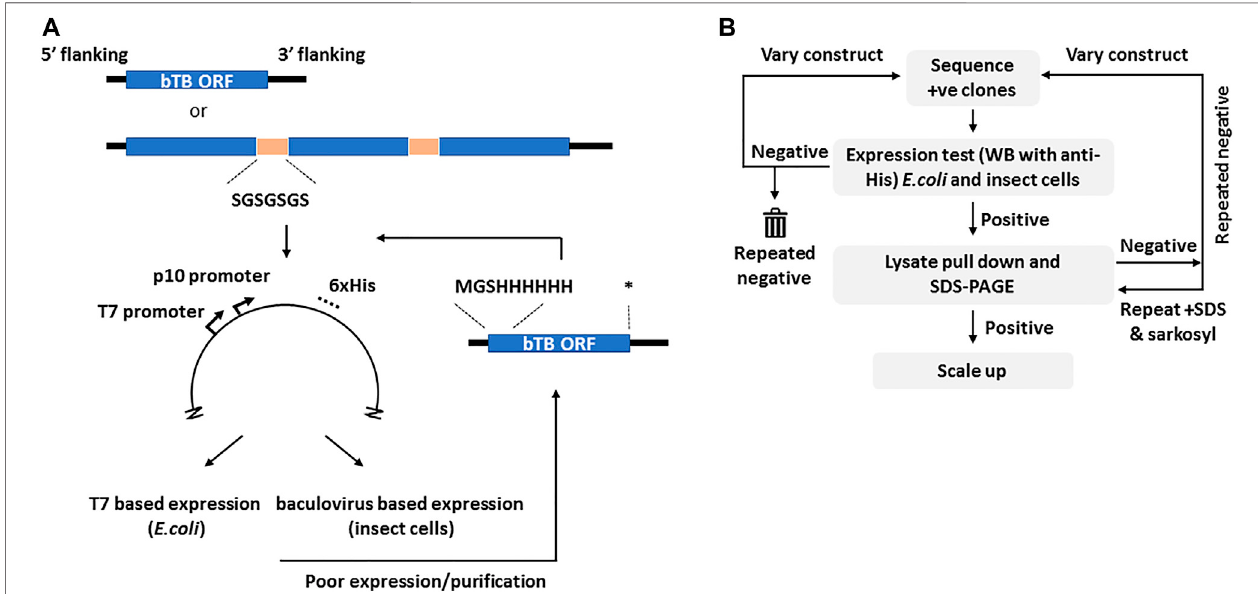
FIGURE 1 | The cloning and selection strategies for the generation of the M. bovis recombinant protein atlas. Panel (A) . Generic construct design showing the use ofeithercompleteorconcatenatedORFstaggedattheC-terminuswithpolyhistidineaspresentinvectorpTriEx1.1.IntheeventofpoorexpressionthesameORFswere re-cloned with an N-terminal His tag as shown. The sequence of the fl exible linker is indicated. Asterisk – stop codon. Panel (B) . The protein expression and puri fi cation regimen showing the iterative nature of the process. The varied constructs are those with alternate His tags shown in (A) . Initial screening was by Western blot for the His tag in all